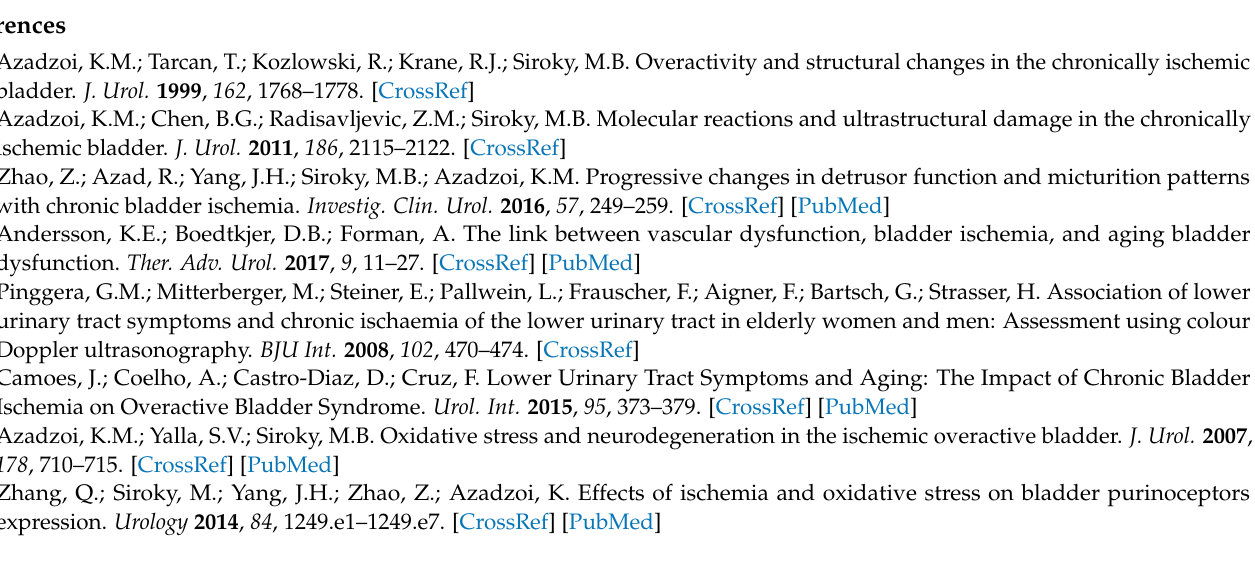
Table S3: Ischemia-associated ncAA-containing proteins (R 2 > 0.5, ratio > 2-fold, p <